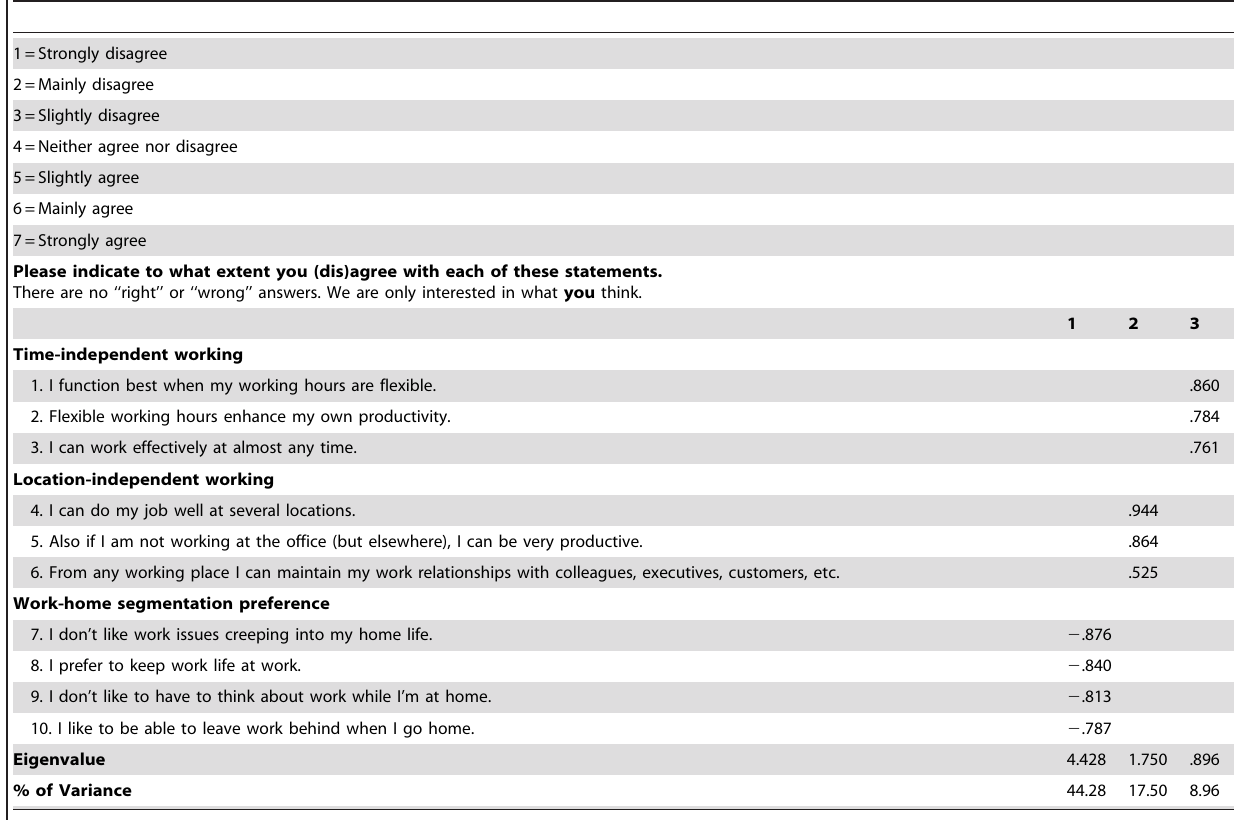
Table 1. Specified Three-Factor Solution of a Principal-Components Analysis of the Two Defining Features of Blended Working and Work-home Segmentation